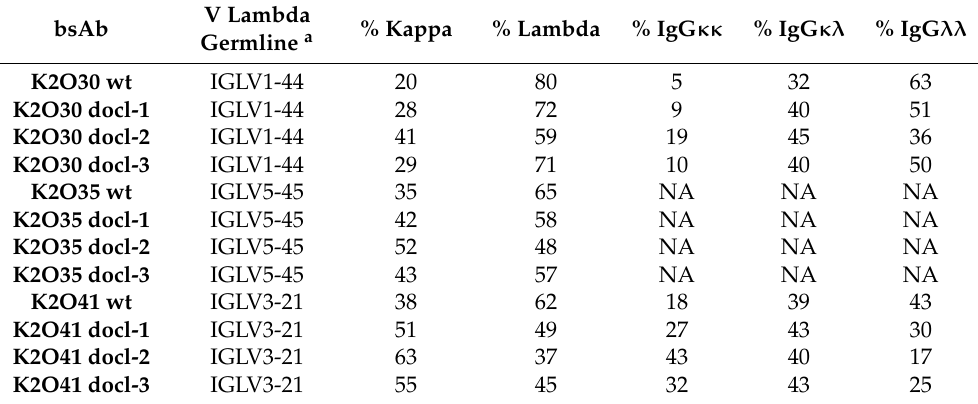
Table 1. Light chain and lgG form distributions in total lgG after transfection in PEAK